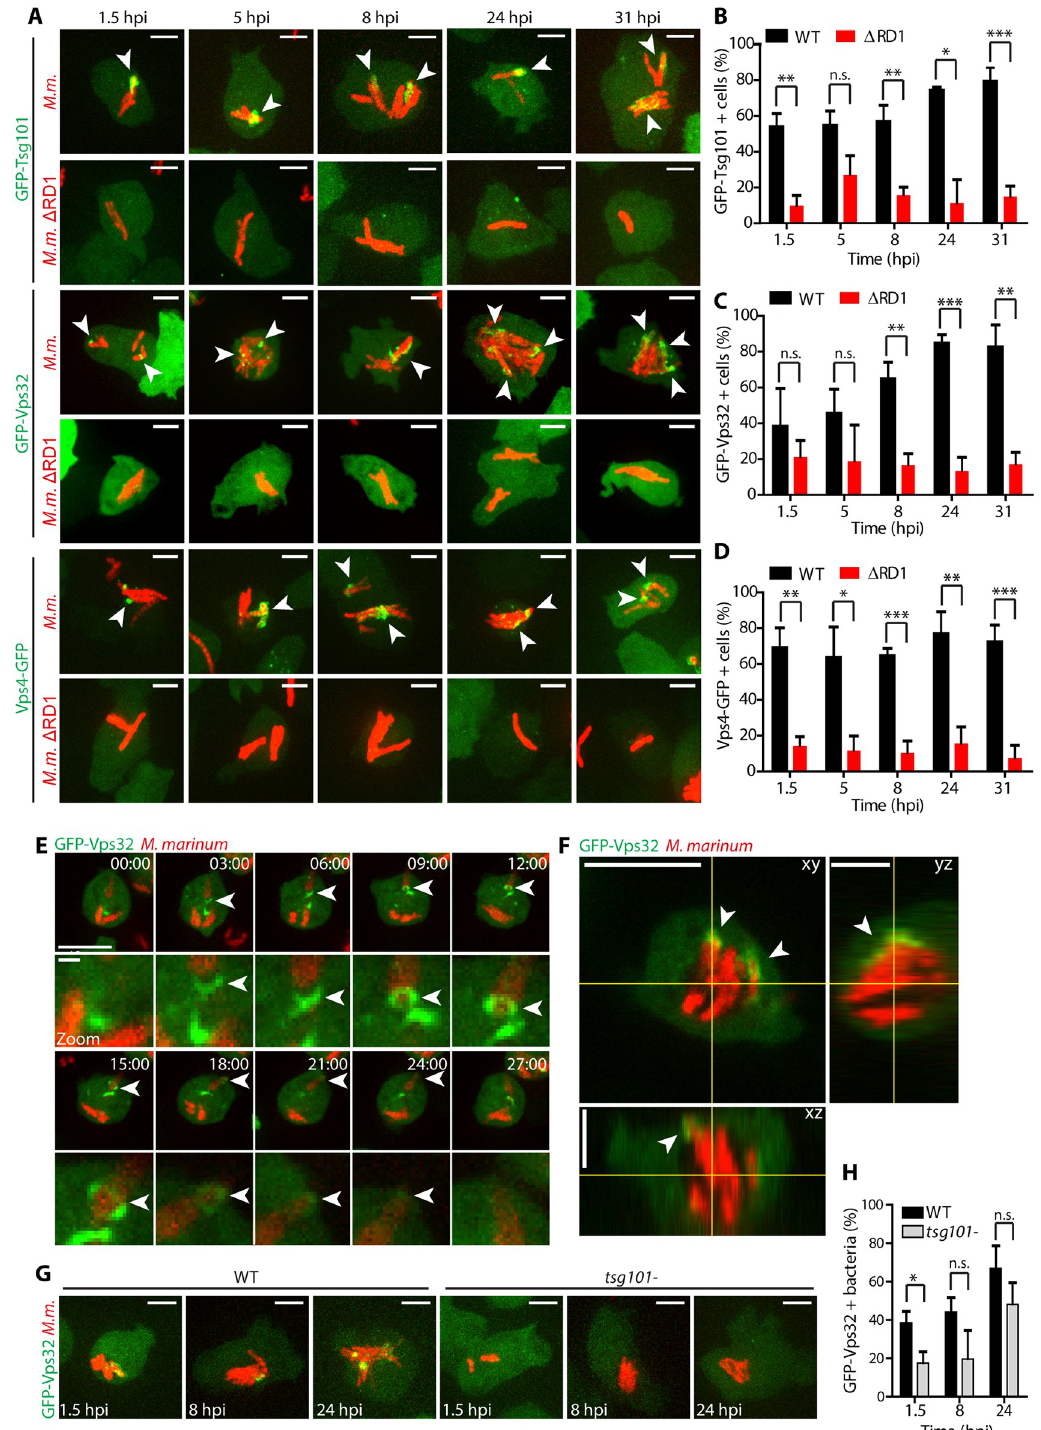
Fig 2. Recruitment of ESCRT components to the MCV upon M . marinum induced damage. (A) D . discoideum expressing GFP-Tsg101, GFP-Vps32 or Vps4-GFP were infected with M . marinum wt or M . marinum Δ RD1, and z-stacks were acquired at 1.5, 5, 8, 24 and 31 hpi. Maximum projections are shown. GFP-Tsg101, GFP-Vps32 and Vps4-GFP structures (white arrows) appeared in the vicinity of the MCV containing M . marinum wt (red), and to a lesser extent around M . marinum Δ RD1 (red).